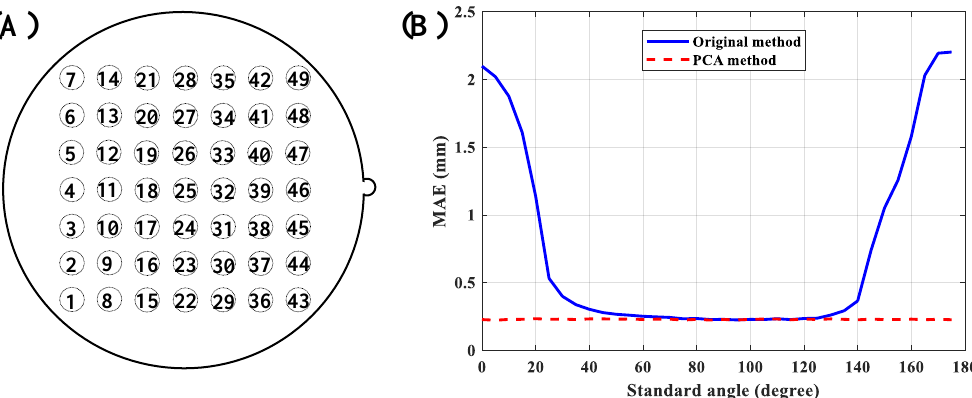
Figure 7. ( A ) indexing of the laser points, ( B ) mean absolute error (MAE) of original and the proposed PCA method for Figure 7. (A) indexing of the laser points, (B) mean absolute error (MAE) of original and the proposed PCA method for different values of standard angle. different values of standard